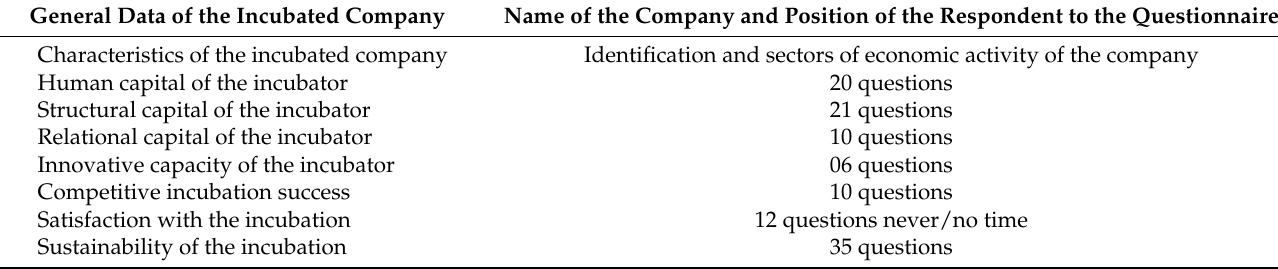
Table 1. Questionnaire